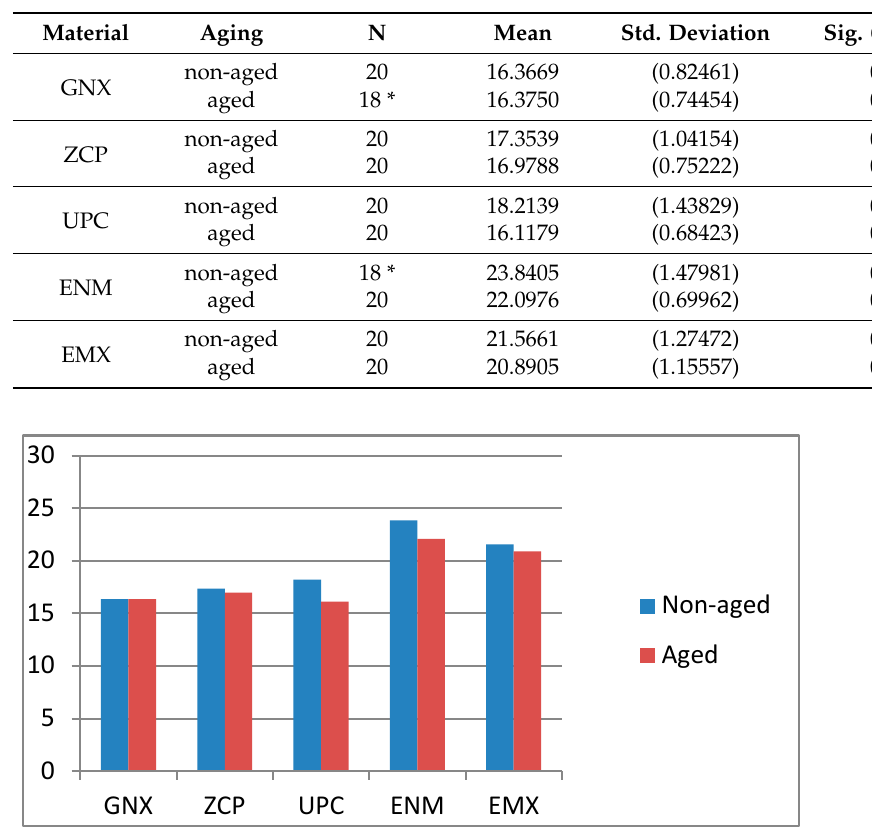
Table 10. Descriptive OP values for the non-aged groups. * Outliers were deleted. Material